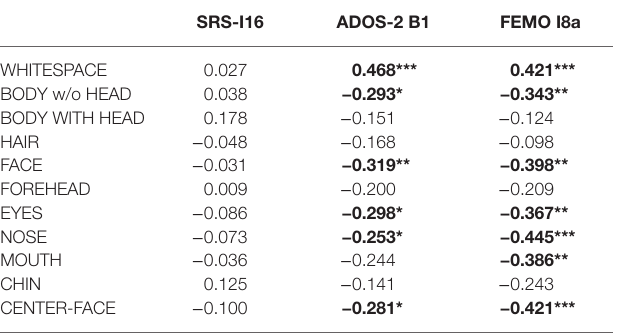
TABLE 4 | Spearman rank-order correlations of AOI-based measures items concerning quality of eye contact.